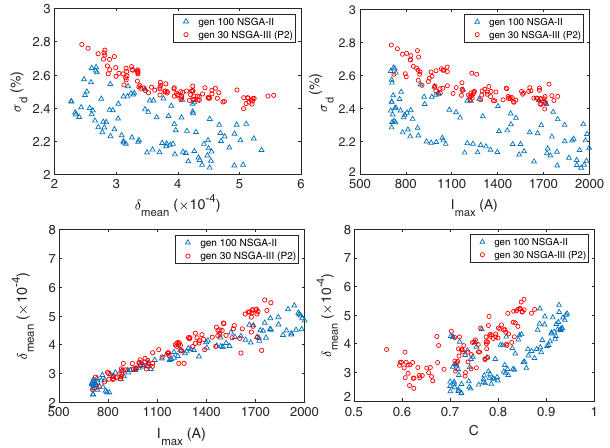
FIG. 13. Projection of the Pareto-optimal front obtained by the NSGA-II (with restrictions on profile factor) and NSGA-III (P2) with a population size of 100 on different